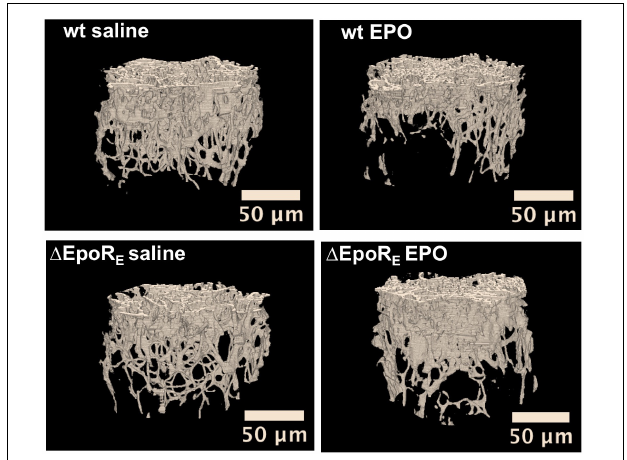
FIGURE 6 | Endogenous and exogenous EPO signaling regulates bone formation. Micro-CT 3D images of trabecular bone from wild type (wt) mice and mice with EPOR restricted to erythroid tissue ( (cid:49) EpoR E ) (Suzuki et al., 2002). Mice (age 8 weeks) were treated with EPO at 1200 U/kg for 10 days (EPO) or saline. Images from saline treatment (left) show reduction in bone formation in (cid:49) EpoR E mice that lack EPOR in non-hematopoietic tissue. Furthermore, the reduction in bone parameters with EPO treatment in wild type mice (top) is not seen in (cid:49) EpoR E mice (bottom) , indicating that bone loss with EPO treatment is mediated by non-erythroid response (from Suresh et al., 2019, with